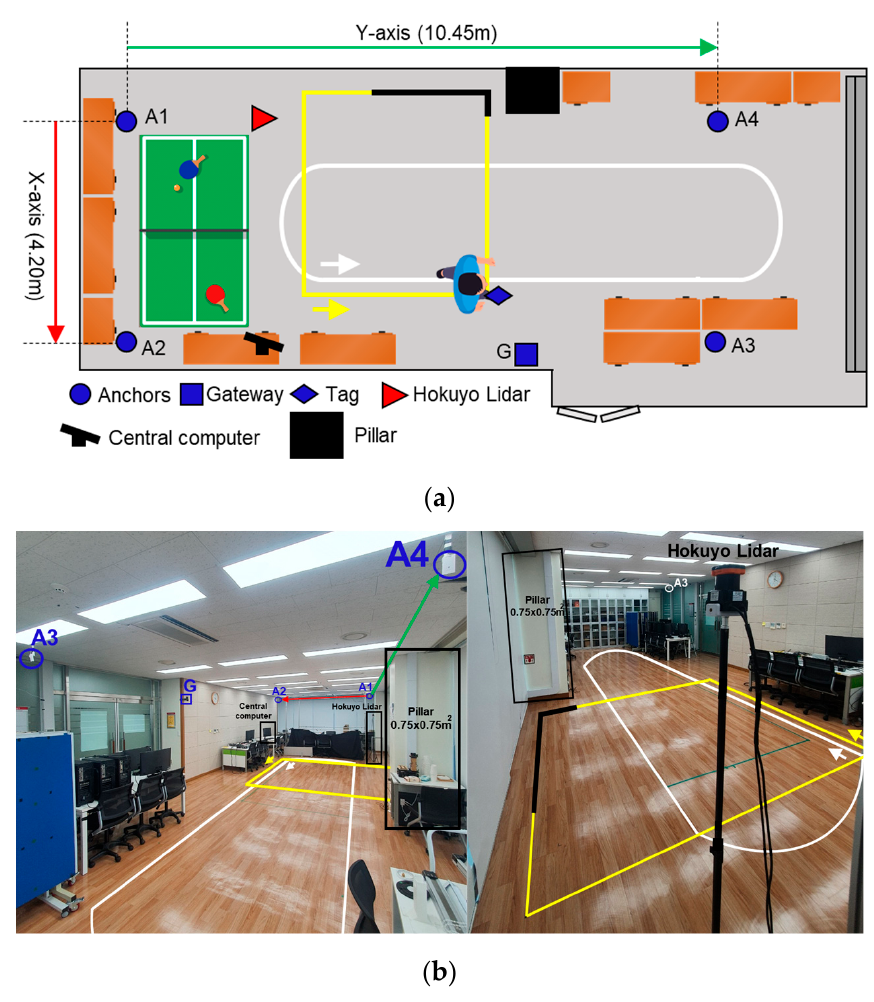
Figure 9. Experiment environment. ( a ) Top view of experimental setup; ( b ) site photos with two views of hardware deployment. Table 2. Experimental setup configuration.